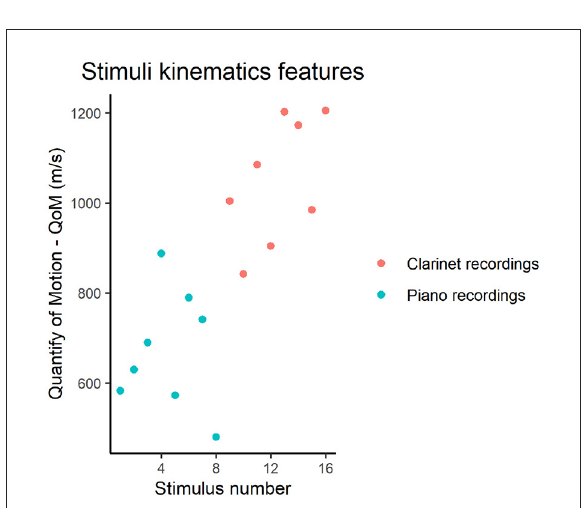
FIGURE2 Kinematics features of the piano and clarinet recordings selected for the current study, showing the overall quantity of motion (QoM) in the y-axis for each stimulus. The QoM for the piano recordings was computed across all the markers applied on the musicians bodies; in addition to these markers, QoM for the clarinet recordings also included motion of the four markers applied on the